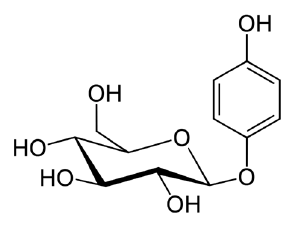
Figure 2. Arbutin Figure 2. Arbutin formula.